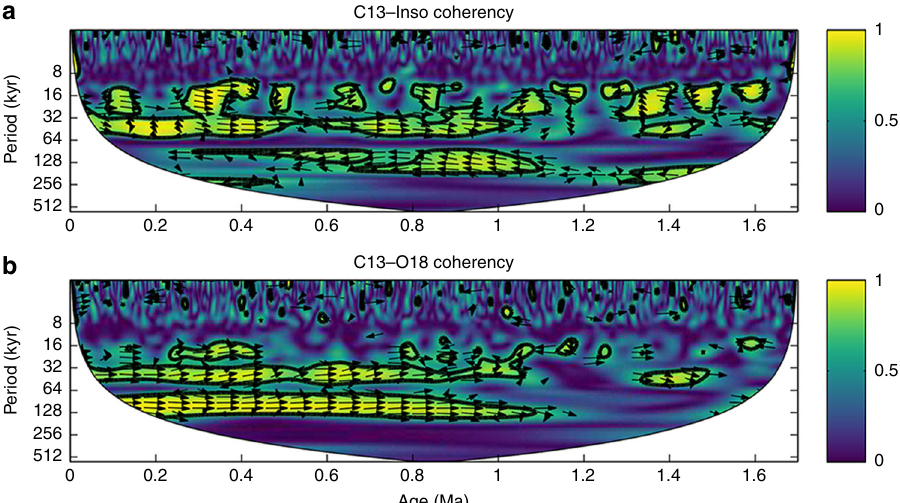
Fig. 8 Cross wavelet spectra. a JY loess δ 13 C IC vs. summer insolation 55 , b JY loess δ 13 C IC vs. benthic δ 18 O stack 3 . Black contours indicate the coherence above 5% signi fi cance level